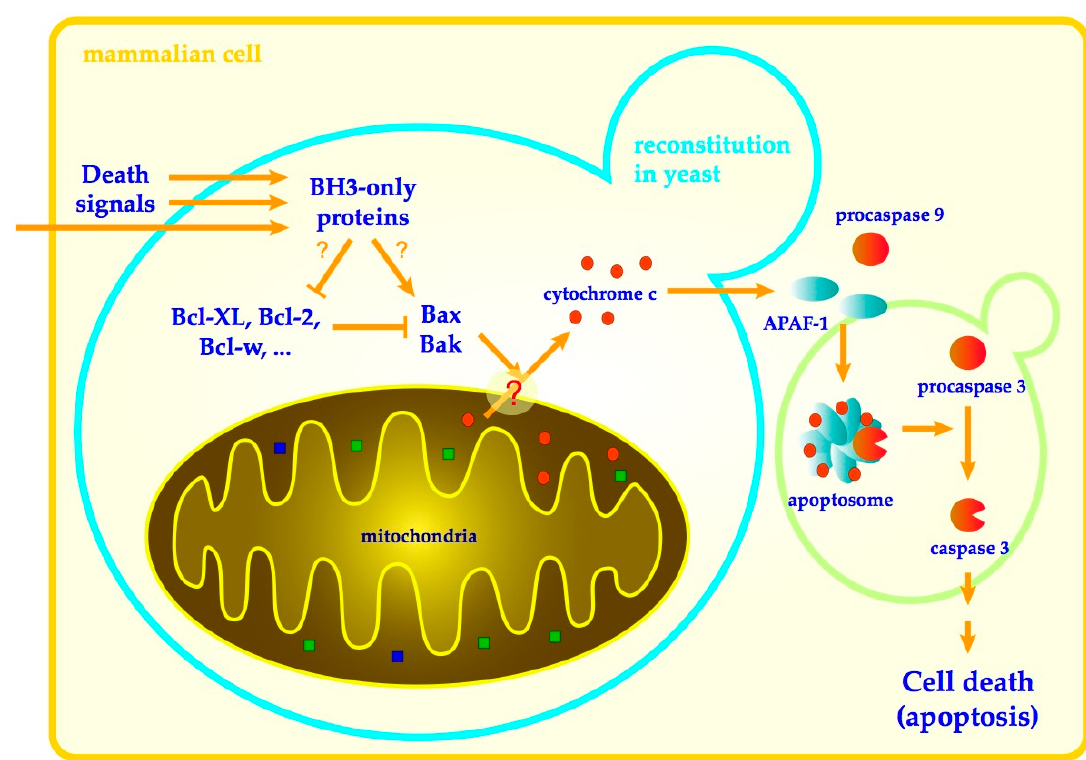
Figure 1. Mitochondrial (intrinsic) apoptotic pathway. Cell death-inducing signals are processed by proteins of the Bcl-2 family. BH3-only proteins in reaction to these signals activate Bax and Bak to permeabilize the outer mitochondrial membrane by either direct interaction or by inhibition of antiapoptotic proteins (e.g., Bcl-XL, Bcl-2). Cytochrome c escapes the permeabilized mitochondria